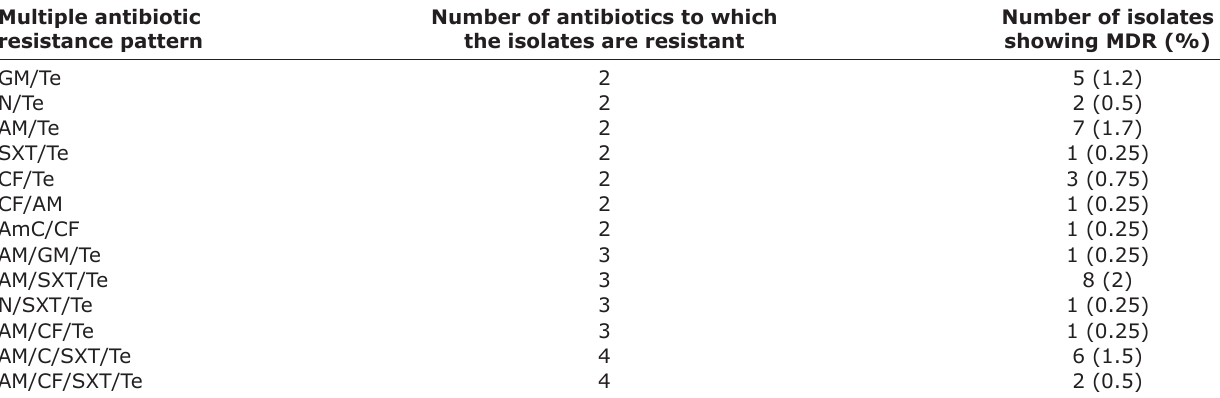
Table-2: MDR patterns of the 39 Escherichia coli isolates from feces of non-diarrheic owned dogs in Grenada. Multiple antibiotic resistance pattern